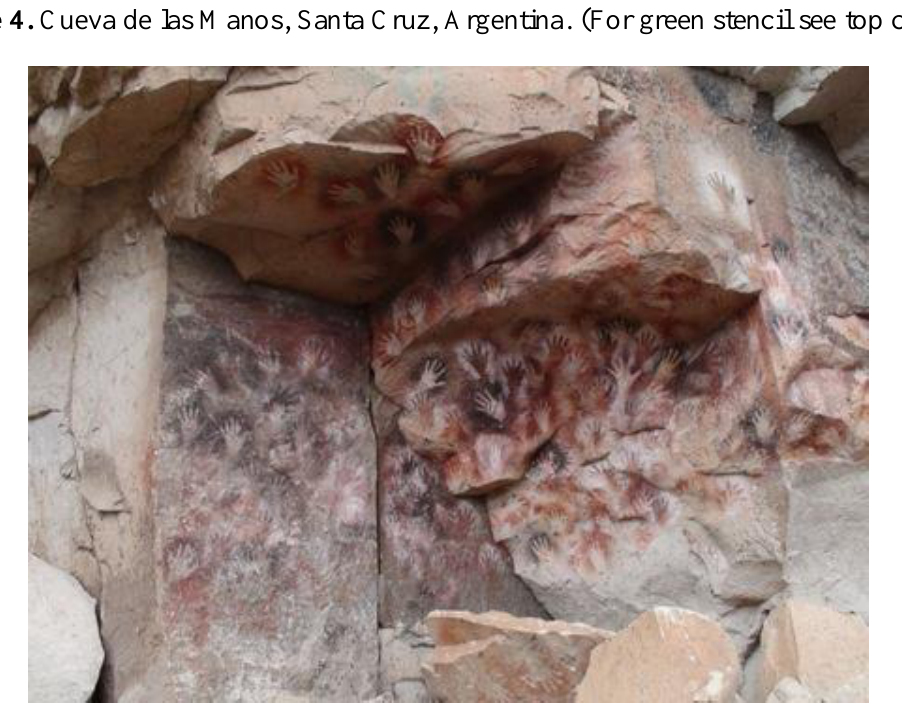
Leroi-Gourhan hypothesizes symbolic alternating red and black color use for stencils at Gargas